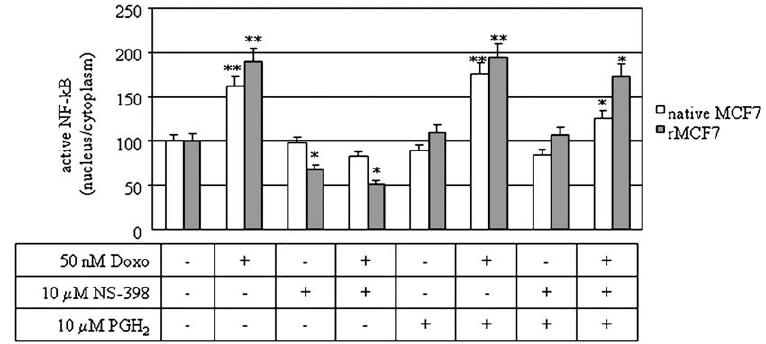
Fig. 5. Effects of PGH 2 on NF- κ B nuclear translocation in native MCF7 cells. Native MCF7 (white bars) and rMCF7 cells (grey bars) were treated for 48 h without or with 50 nM Doxo, 10 µM NS-398, 10 µM PGH 2 alone or in combination. NF- κ B/p65 content was then evalu- ated in cytoplasmic and nuclear proteins by ELISA. Results are expressed as the mean ± SE percent active NF- κ B (nuclear to cytoplasmic NF- κ B immunoreactivity ratio) in treated samples as compared to untreated control cells. All experiments were carried out at least three times independently. * p < 0 . 05 and ** p < 0 . 01 vs. untreated control